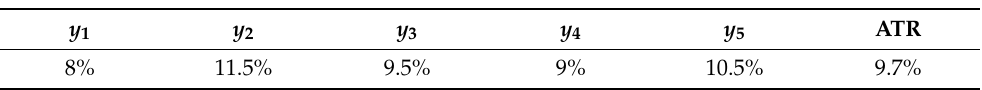
Table 4. Inter-layer quasi-synchronization (RLQS): Triggering rates for nodes under condition (11). y 1 y 2 y 3